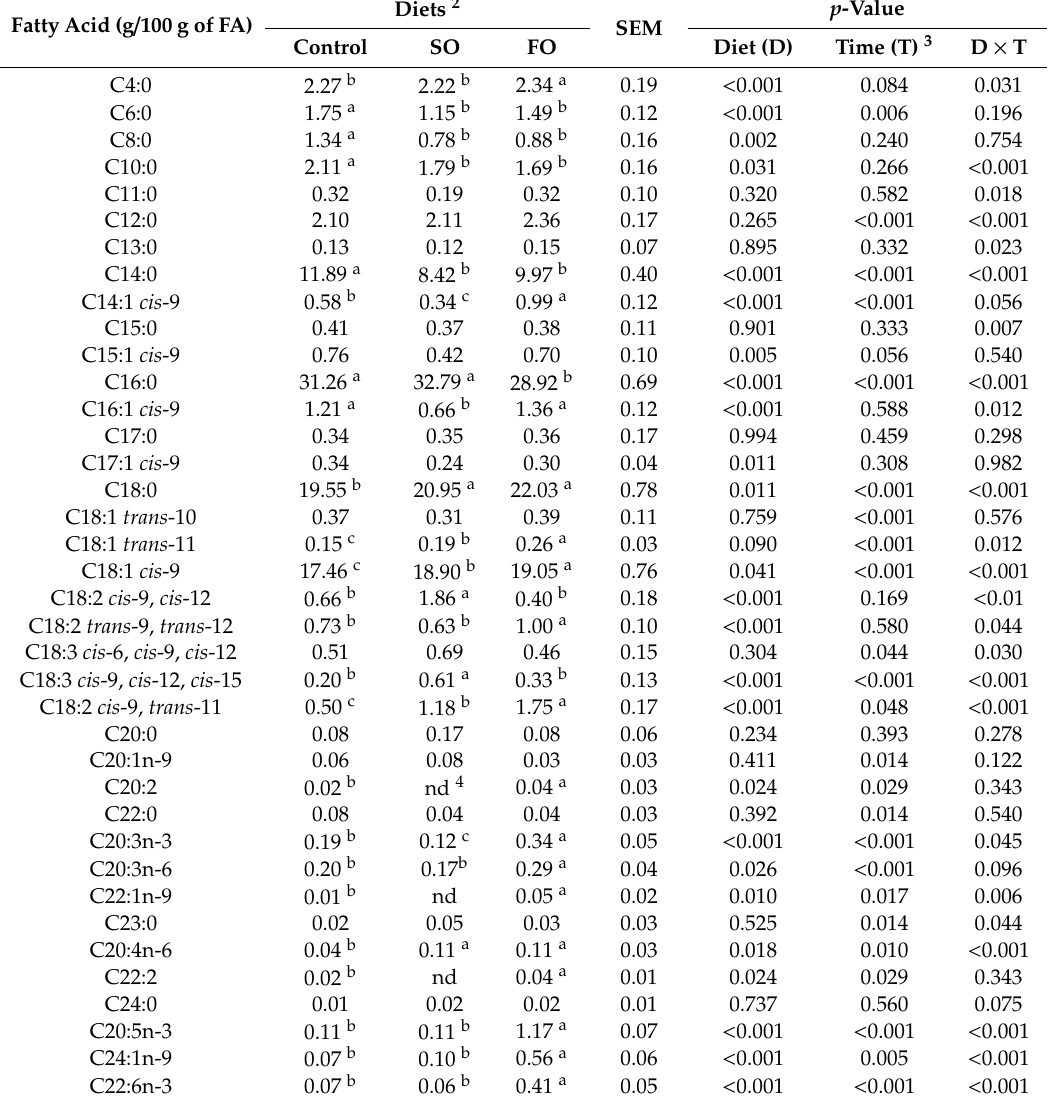
Table 3. Milk fatty acid profile from cows supplemented with control, soybean oil (SO), and fish oil (FO) 1 . Fatty Acid (g / 100 g of